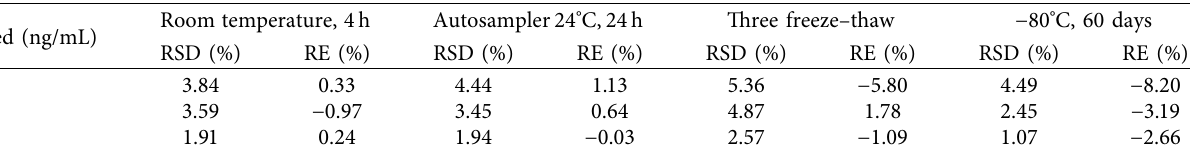
Table 4: Stability of tropifexor in beagle plasma subjected to various conditions ( n � 6).